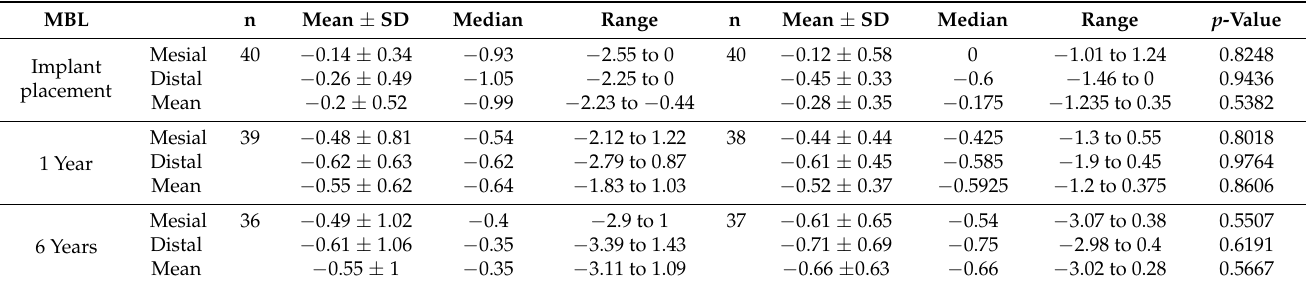
Table 3. Correlation between marginal bone level (MBL) and postoperative time. SD, standard deviation.